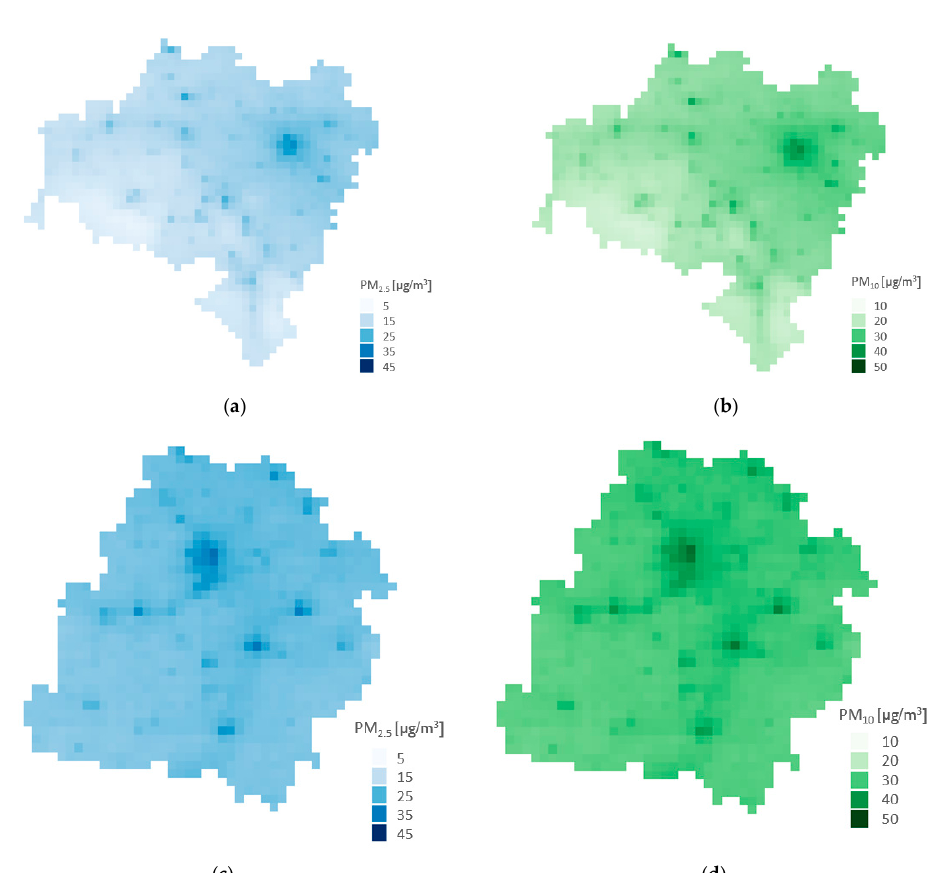
Figure 1. ( a ) Baseline annual concentration of PM 2.5 weighted with population, Lower Silesia, Poland; ( b ) baseline annual concentration of PM 10 weighted with population, Lower Silesia, Poland; ( c ) baseline annual concentration of PM 2.5 weighted with population, Lodzkie province, Poland; and ( d ) baseline annual concentration of PM 10 weighted with population, Lodzkie province, Poland.